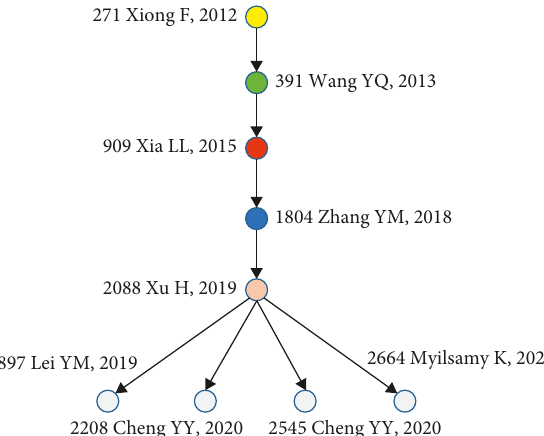
Figure 7: Local backward main path in dynamic complex network